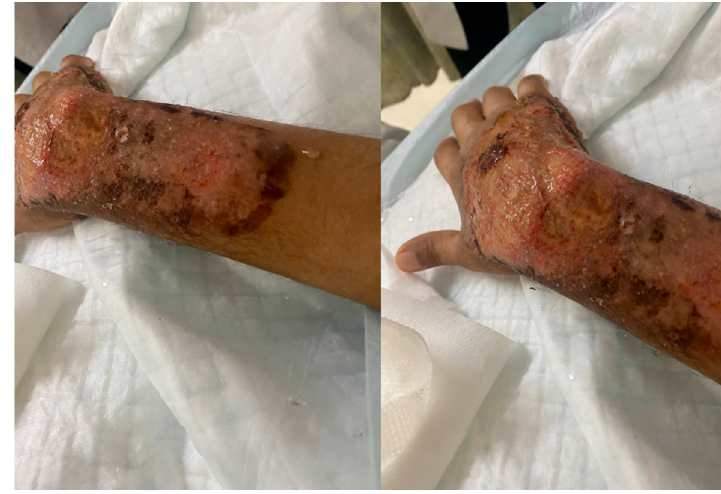
Figure 4. Resolution of swelling and eschar post treatment.